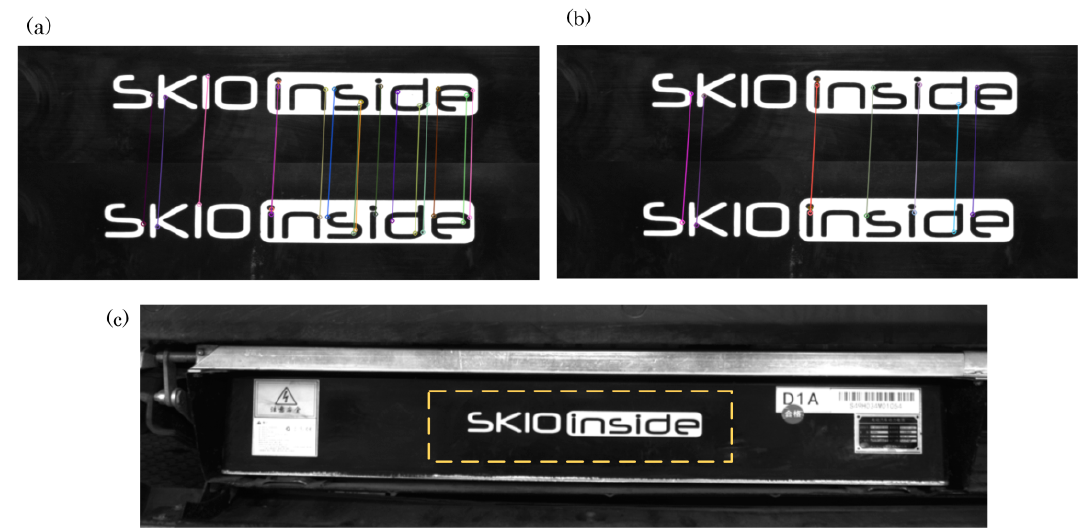
Figure 6. Most reliable matched keypoints ( a ) Sixteen candidate-points ( b ) Eight base-points ( c ) Battery of electric automobile.